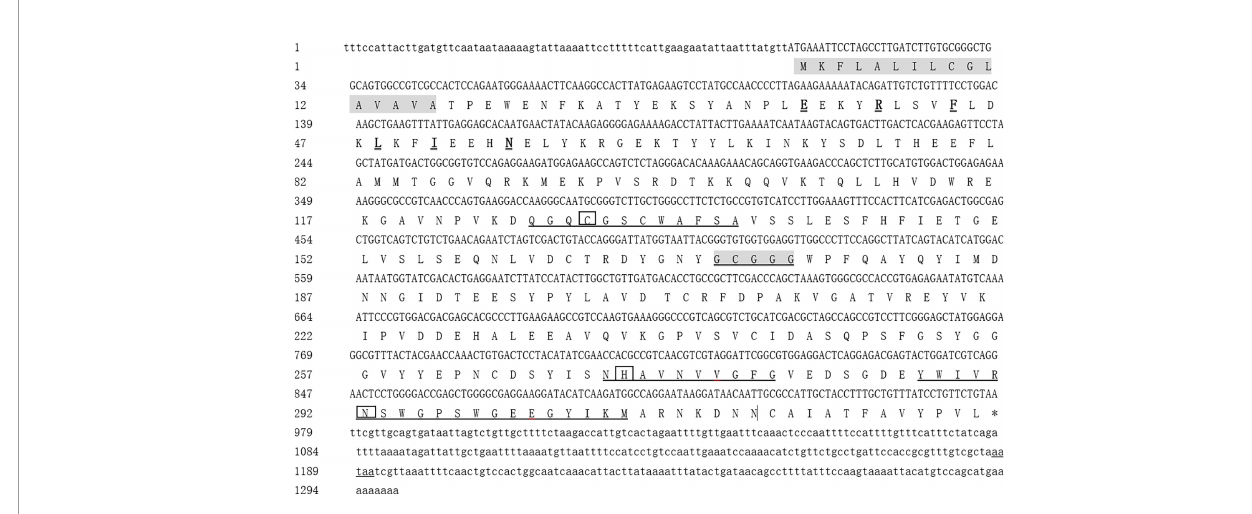
FIGURE 1 | Full cDNA sequence and predicted amino acid sequence of Mn-CL2 in M. nipponense . The shaded area indicates the signal peptide. The black underlined boxes represent the active sites of cysteine, histidine, and asparagine. The cathepsin L signature sequences E-X 3 -R-X 2 -I-F-X 3 -N-X 3 -I-X 3 -N were in bold and bigger fonts with double line and GCXGG were shown in shadow underlined. The conserved catalytic triad residues (Cys, His, Asn) are boxed, and its amino sequences are underlined. The asterisk (*) represents the termination codon. The polyadenylation tail signal is underlined.